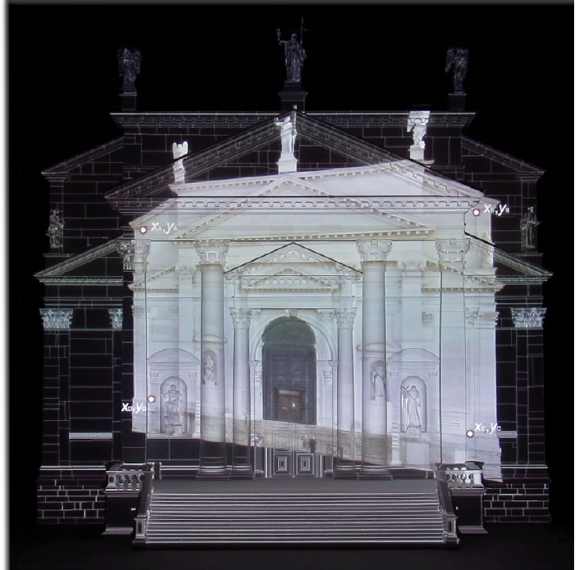
Figure 2. For each pair of homologous points it is possible to define 2 equations